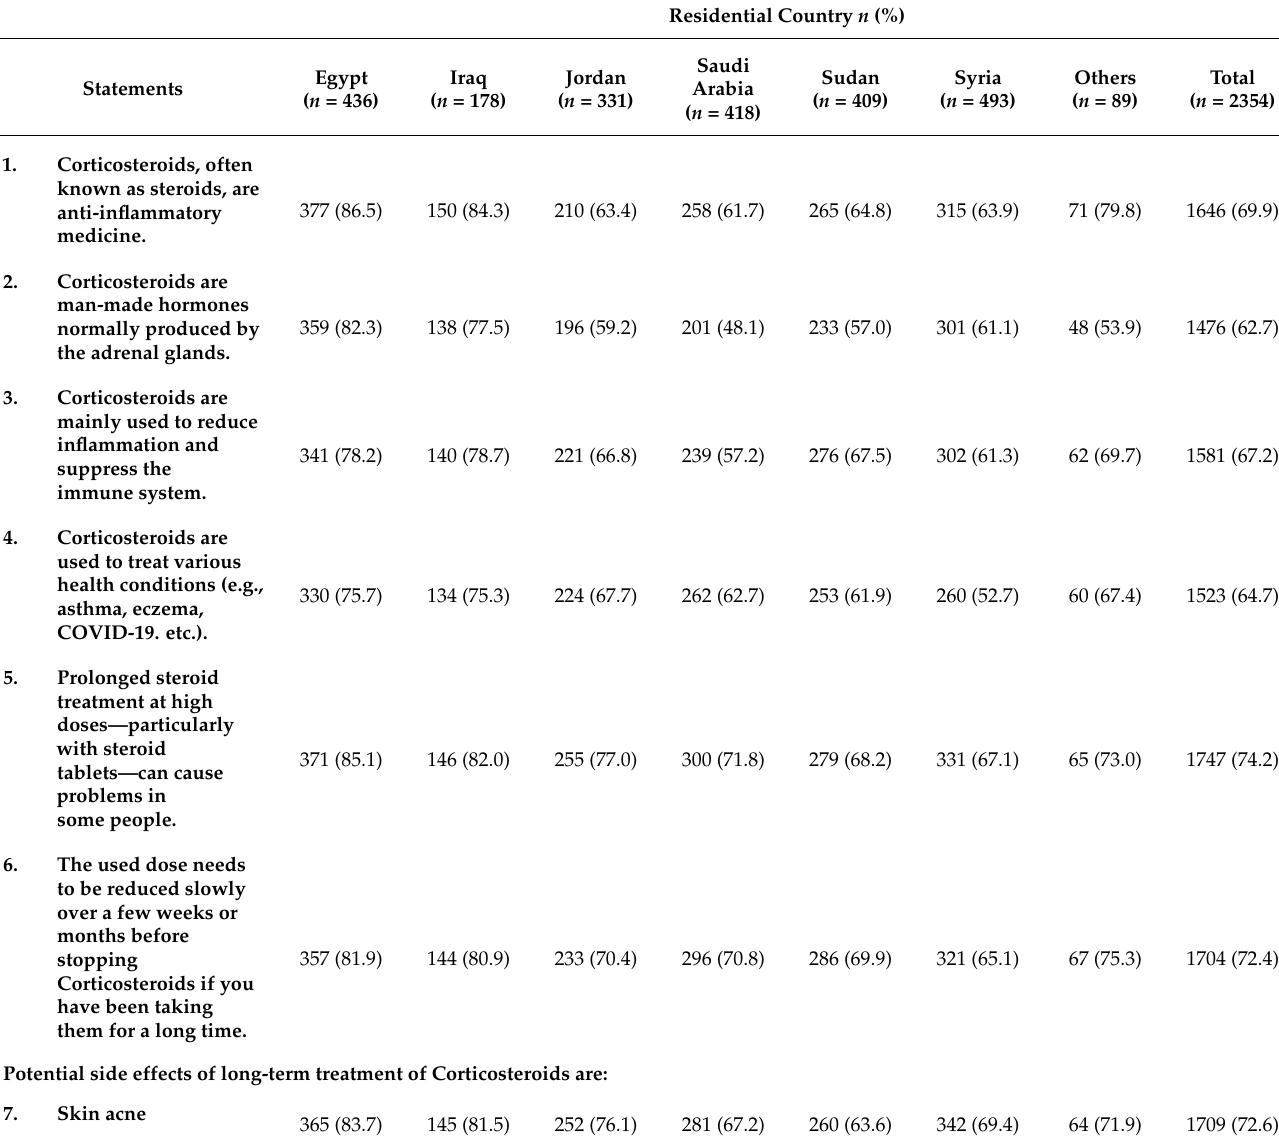
Table 4 shows participants’ frequencies (percentages) of correct answers to the 14 knowledge questions about corticosteroids from the different countries. Table 4. Participants’ frequencies (percentages) of correct answers to the knowledge questions about corticosteroids from the different